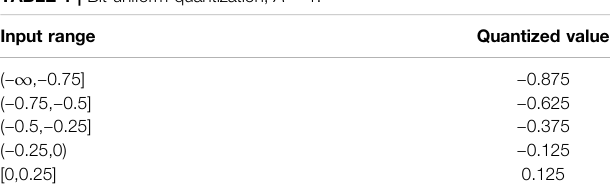
TABLE 1 | Bit uniform quantization, A (cid:1) 1.